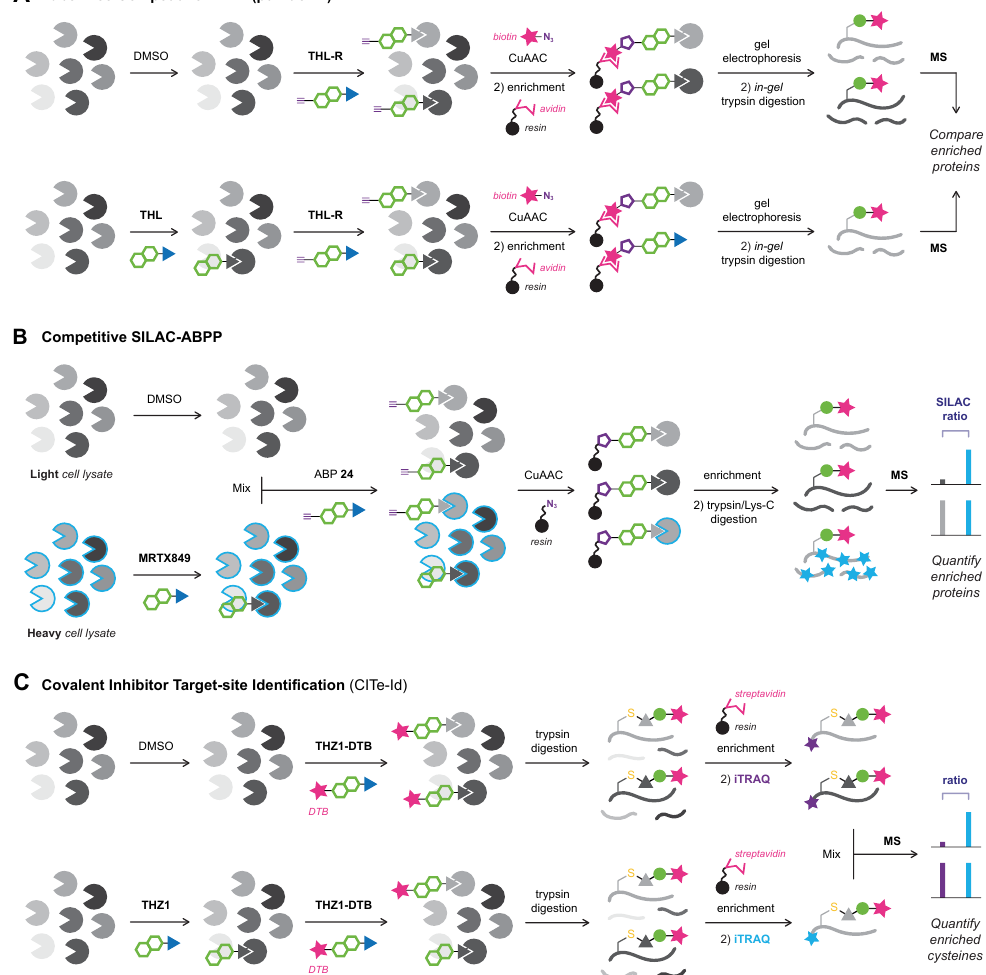
Figure 11. Chemoproteomic approaches to identify covalently modified (off-)target proteins in whole proteomes. Pretreatment with inhibitor blocks drug-derived ABP binding and protein enrichment, resulting in a lower abundance of target protein compared to the DMSO-treated (control)